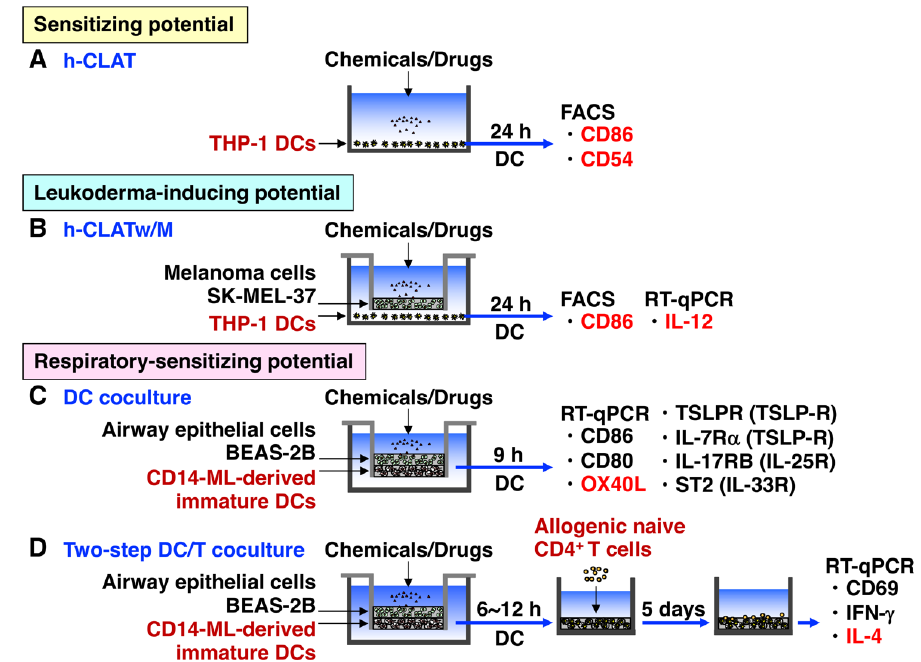
Figure 2. In vitro cell culture systems created for predicting the sensitizing potential and allergenicity of chemicals and drugs. Due to the current limited utilization of animal experimentation for risk evaluation, several in vitro cell culture systems as alternative methods have been developed to predict the sensitizing potential and allergenicity of chemicals and drugs. ( A ) The h-CLAT is an in vitro evaluation method widely used as a guideline test for predicting the skin sensitizing potential of chemicals by measuring CD86 and CD54 on THP-1 cells, DC surrogate cells. However, h-CLAT is disadvantaged in not being able to evaluate pro-haptens, because THP-1 cells only have limited metabolic capacity. ( B ) The h-CLAT-w/M system consists of THP-1 cells and melanoma SK-MEL-37 cells, as surrogate melanocytes are established. This system is useful for evaluating whether whitening agents that target melanocytes, especially tyrosinase, cause leukoderma as an adverse effect. Using the h-CLAT-w/M, RD was shown to act on melanocytes, generate ROS, release ATP, and consequently upregulate CD86 and IL-12 in THP-1 cells, potentially leading to the generation of melanocyte-specific CTLs and eventually leukoderma. ( C ) The DC coculture system consists of the human upper airway epithelial cell line BEAS-2B cells, and human peripheral monocyte-derived proliferating cell line CD14-ML cells. This system successfully discriminates typical chemical respiratory sensitizers from typical skin sensitizers by measuring the mRNA expression of one of the critical molecules for Th2 differentiation in DCs, OX40L. ( D ) To more precisely reproduce the in vivo activation and migration of naive CD4 + T cells after stimulation with DCs treated by chemical sensitizers, a new two-step DC/T cell coculture system was established by further adding peripheral allogeneic naive CD4 + T cells to the DCs stimulated in the DC coculture system. In this two-step DC/T cell coculture system, the mRNA upregulation of IL-4 in T cells representing KE4 was successfully used to discriminate typical respiratory sensitizers from skin sensitizers.